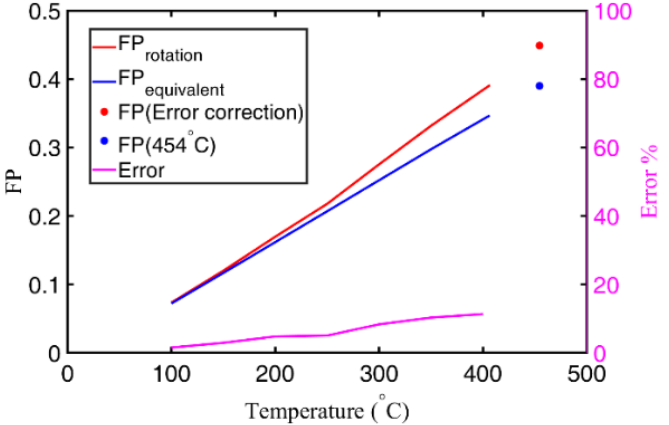
Figure 10. Fatigue parameter comparison between rotating loading and equivalent methods.